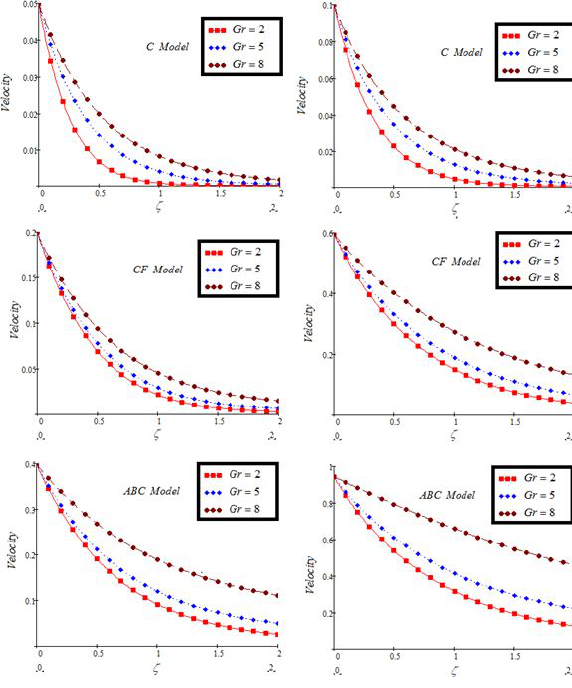
Figure 7: Velocity profile for FD’s with variation of ϖ and Gr = 5,